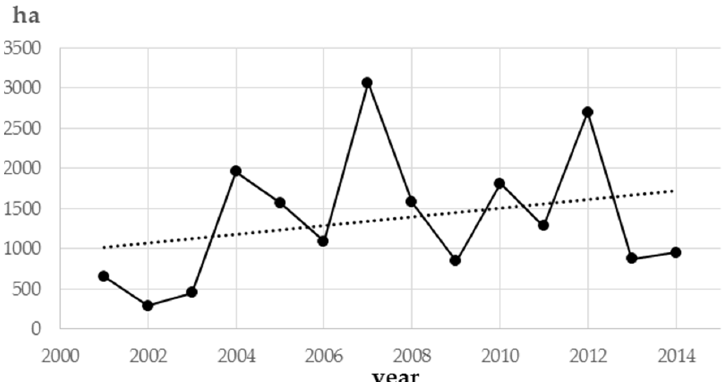
Figure 2. Deforestation rates in Maramure ș County (2001–2014)